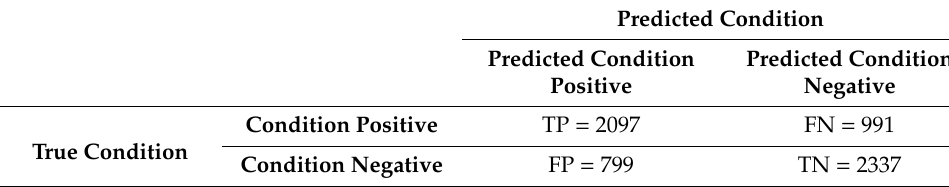
Table 8. Confusion matrix for SVM. (TP: true positive, TN: true negative, FN: false negative, FP: false